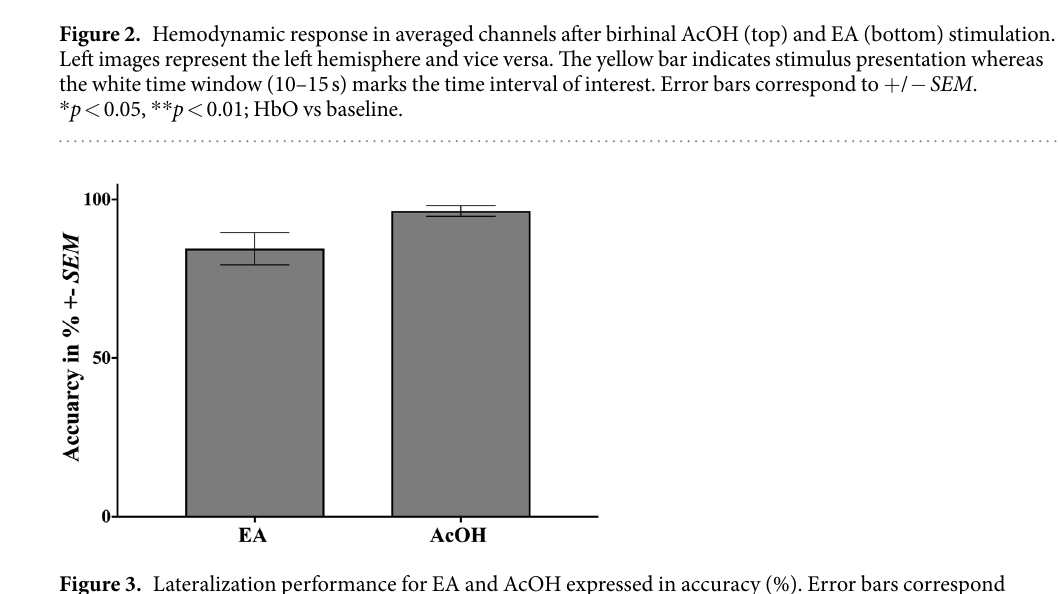
Figure 3. Lateralization performance for EA and AcOH expressed in accuracy (%). Error bars correspond to + / − SEM